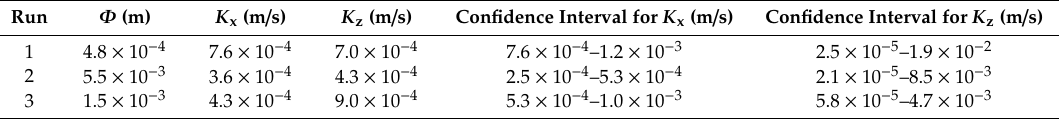
Figure 6. Numerical model Simulation 2 of IFL development and transient evolution. The dimensions of each cross-section match the numerical model domain of 2.0 m (L) × 0.5 m (H) × 0.10 m (W). Table 4. The objective function ( Φ ), hydraulic conductivity estimates ( K x , K z ), and confidence intervals for the numerical simulations using the parameter estimation tool (PEST) tool.